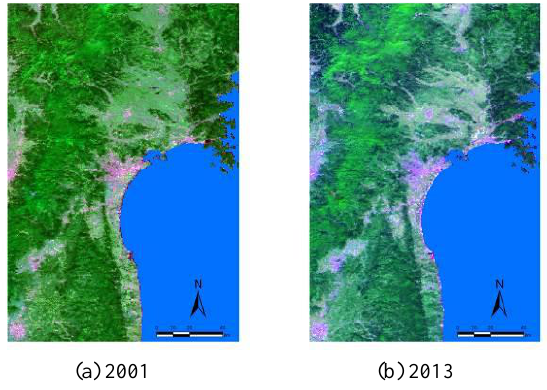
Figure 2(a), (b). Natural colour images derived from monthly composite Terra/MODIS data for September of 2001 (a: left)